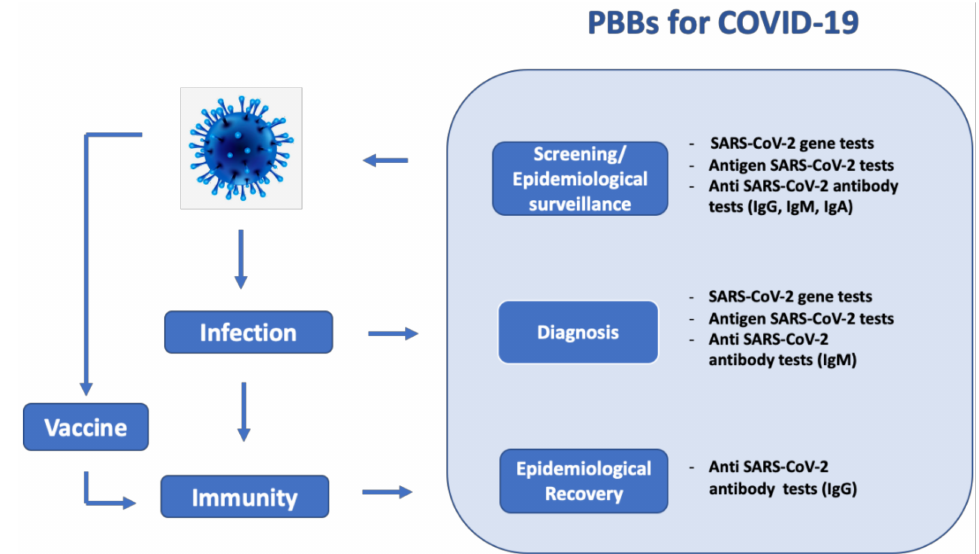
Figure 1. The important role of paper-based biosensor (PBB) diagnostics tests in the context of the Coronavirus disease 2019 (COVID-19) pandemic for screening, diagnosis and epidemiological